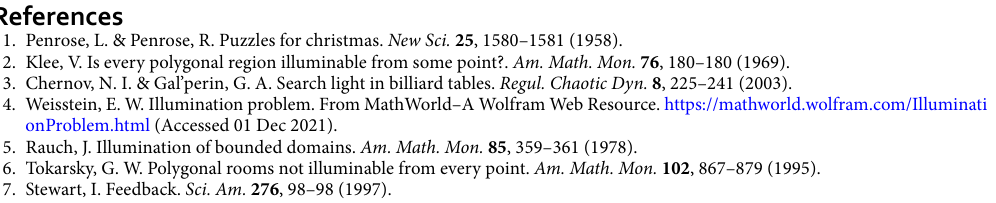
the following boundary conditions.